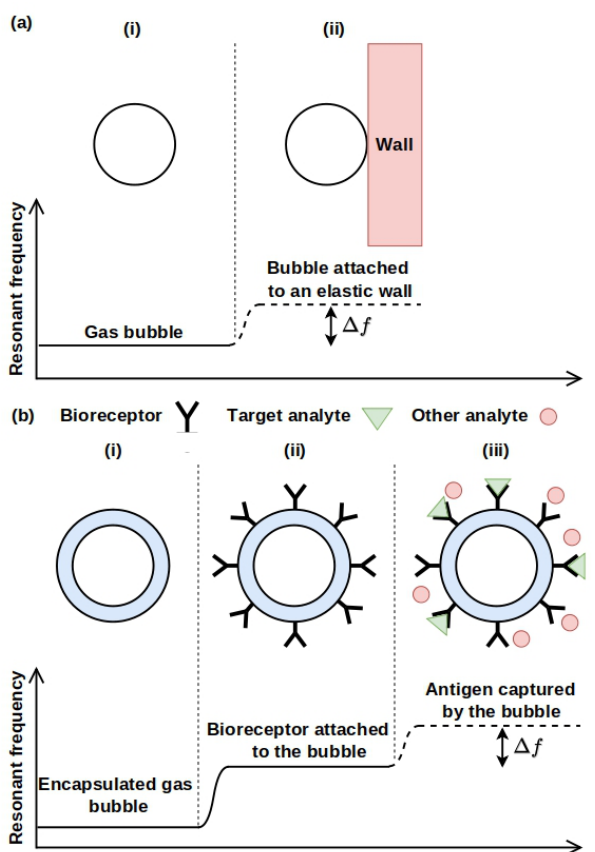
Figure 2. ( a ) Schematic of the operating principle of gas bubble-based sensors for probing mechanical properties of an elastic wall (e.g., a wall of a blood vessel wall or a biological cell). In a practical realisation, microbubble oscillations are driven by ultrasound waves. The resonance frequency shift ∆ f caused by the approach of the bubble to a wall is detected using a technically simple integrated electronic circuit. At the post-processing step, the measured value of ∆ f is correlated with the values of material parameters that characterise elastic properties of the wall as discussed in Section 2. ( b ) Illustration of complementary biochemical sensing properties of gas bubble sensors shown in panel ( a ). The resonance frequency f of a microbubble (stage (i)) first increases when its surface is functionalised using a biorecognition ligand (e.g., an antibody, stage (ii)). It increases further when the bubble covered by an antibody captures analyte (stage (iii)), thereby resulting in a modification ∆ f of the resonant frequency that is detected using the same approach as in panel ( a